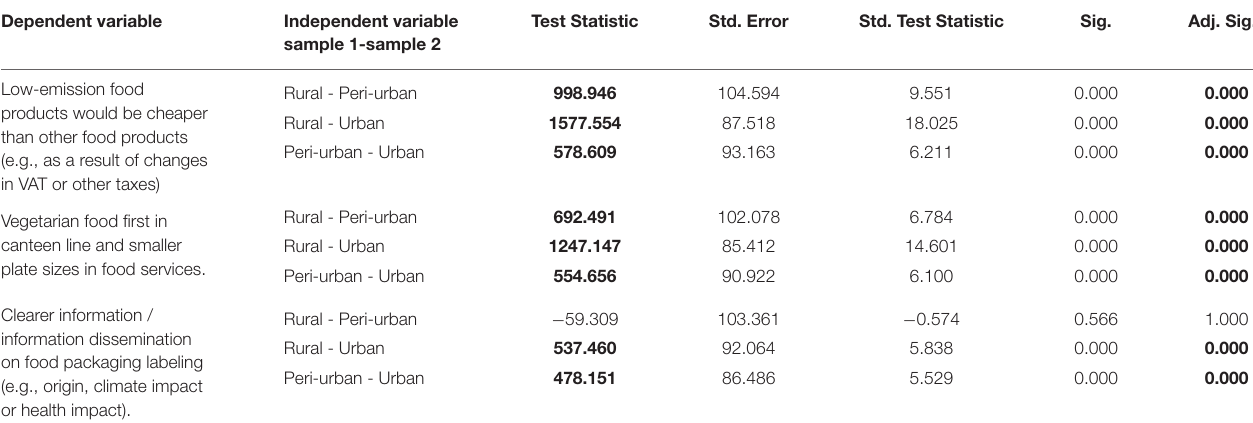
TABLE 2 | Food related policy options. How much would the measure affect the food choices? Pairwise comparisons. Dependent